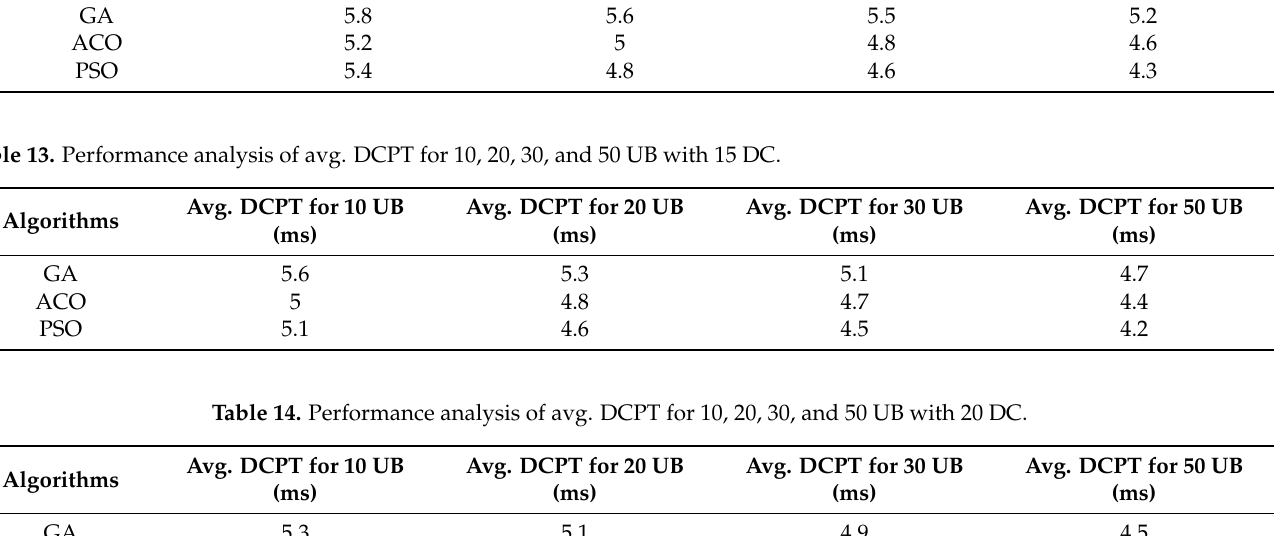
Table 12. Performance analysis of avg. DCPT for 10, 20, 30, and 50 UB with 10 DC. Algorithms